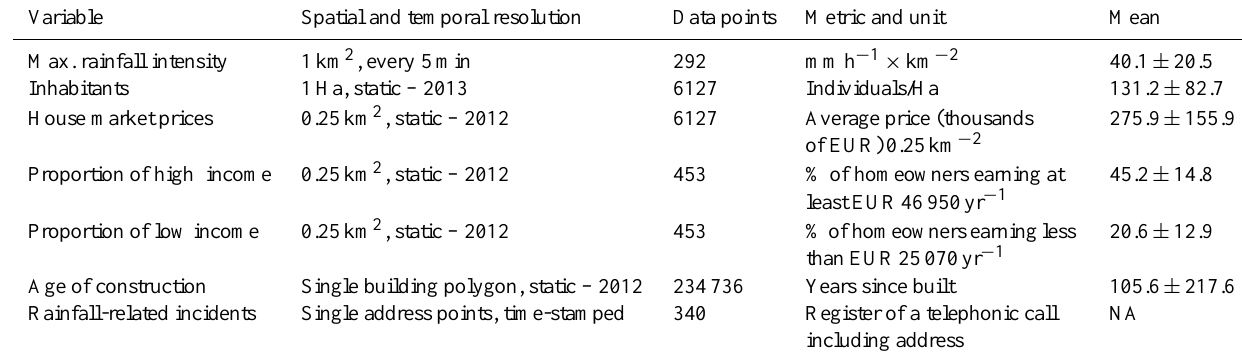
Table 1. Data sources used in this study. Total number of data points and mean refer only to case study area. Points with secret or not available data have been excluded from this table. Only buildings in use have been